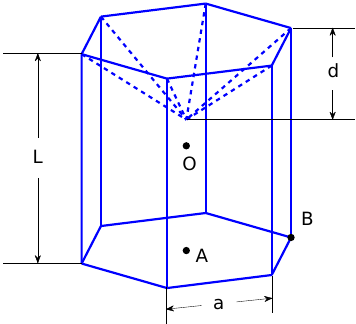
Figure 1. Geometry of a hexagonal column with a hollow structure. L is equal to the maximum dimension D for the hexagonal column.